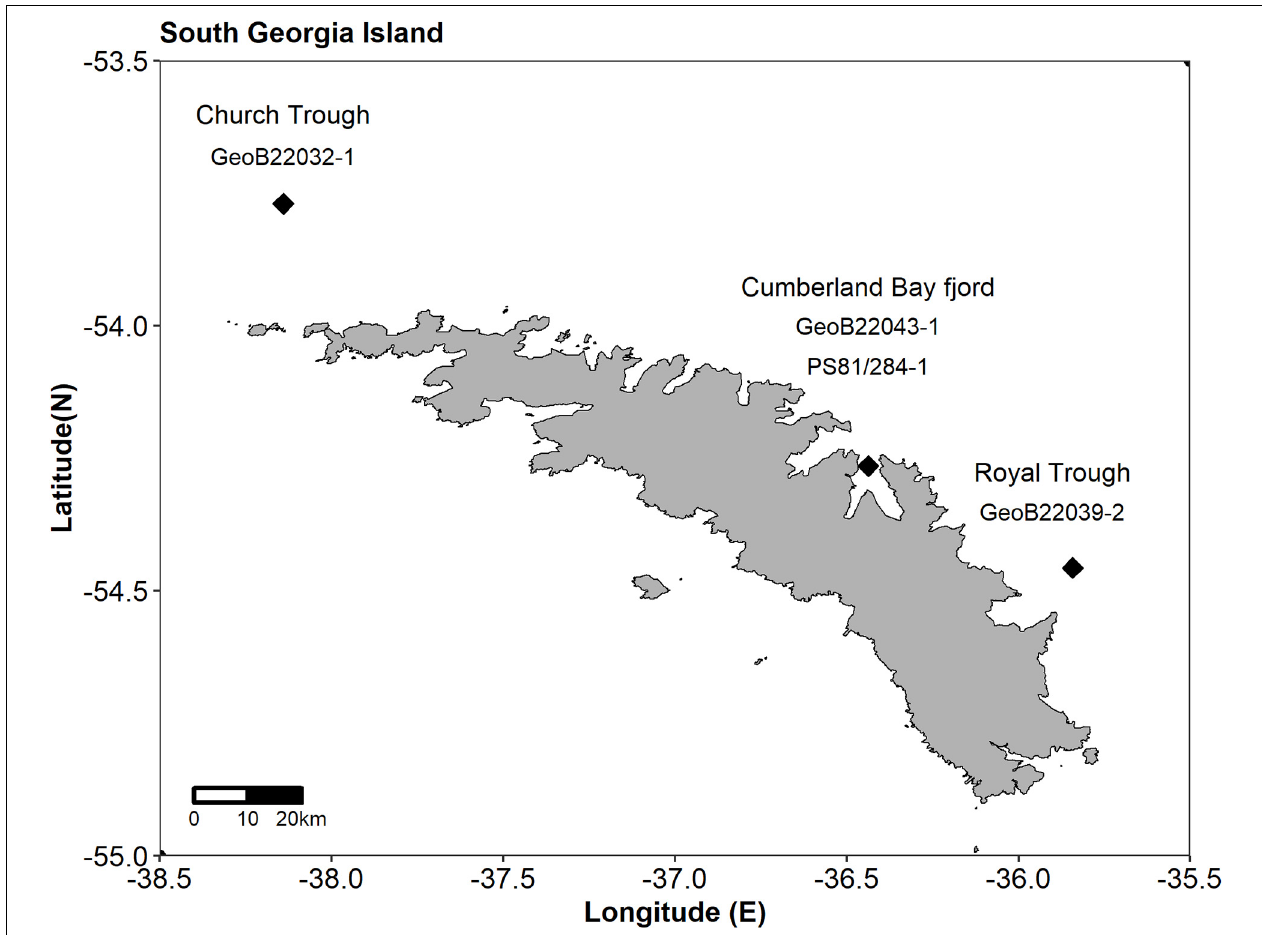
FIGURE 1 | Map of South Georgia and sampling locations marked by diamonds. In west to east direction these are: Church Trough (GeoB22032-1), Cumberland Bay (GeoB22043-1, PS81/284-1) and Royal Trough (GeoB22039-2). In the Cumberland Bay fjord the two cores PS81/284-1 and GeoB22043-1 were taken in close proximity during two separate cruises as indicated by the black